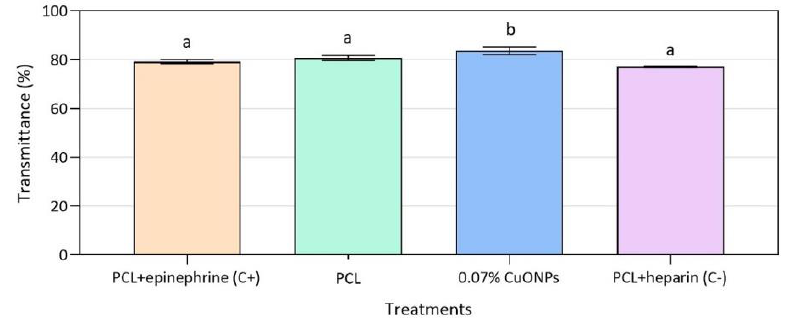
Figure 8. Platelet aggregation of human plasma on active PCL and neat PCL films after 3 min exposure. Mean values with different letters represent significant differences ( p < 0.05) among the samples as determined with a one-way analysis of variance (ANOVA) and Tukey’s multiple comparison tests.